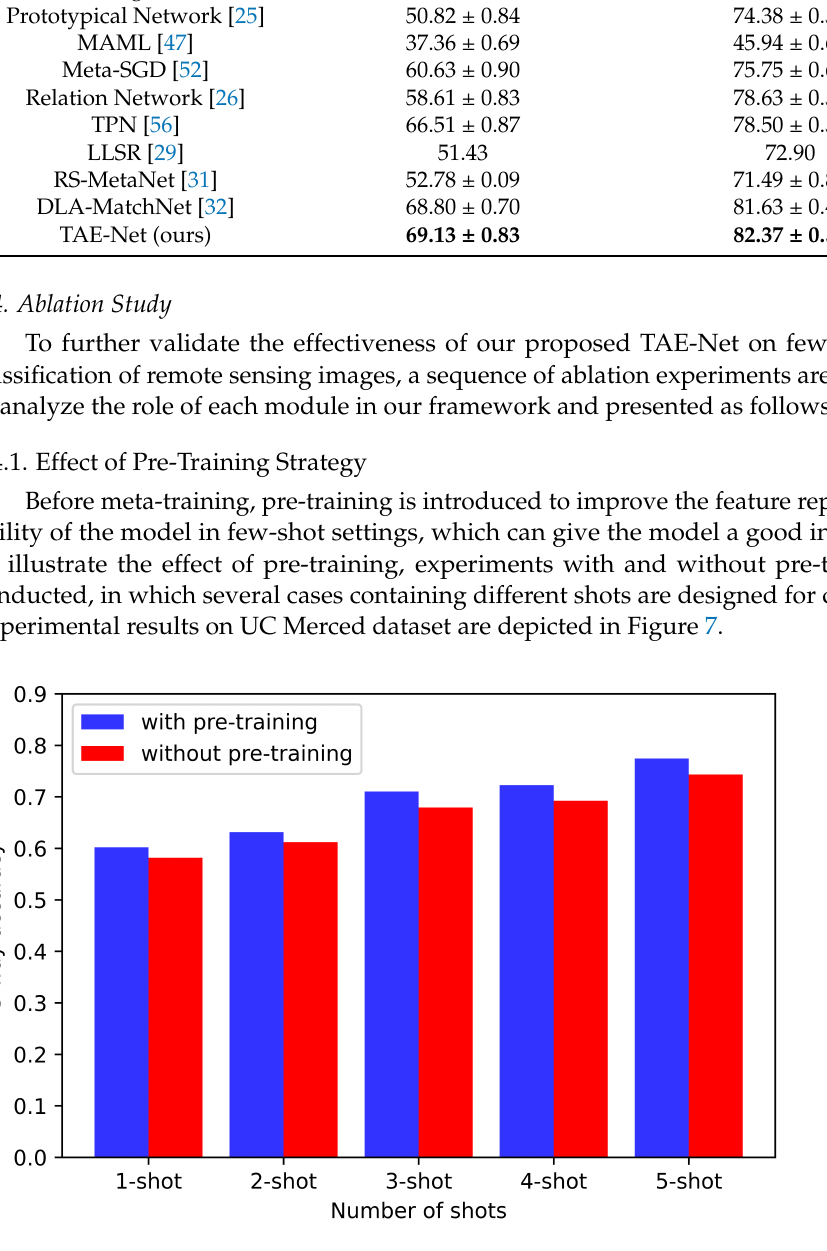
Figure 7. Classification accuracies with different number of shots on UC Merced